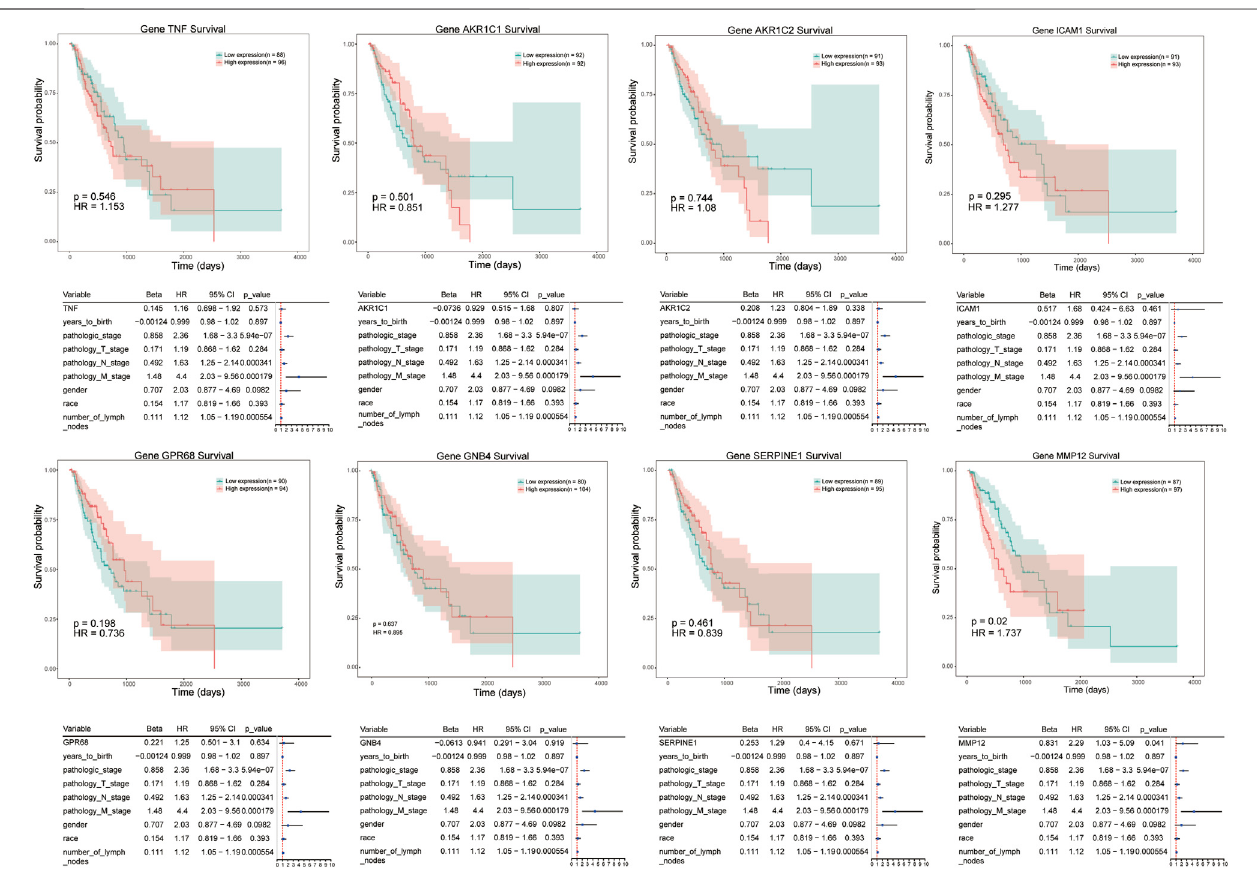
FIGURE 5 | Kaplan – Meier survival curves of candidate genes in ESCC, including TNF, AKR1C1, ICAM1, MMP12, et al. Red line represents high expression of crucial genes while green line refers to low expression genes. The X axis represent overall survival time (day), and Y axis means survival probability.